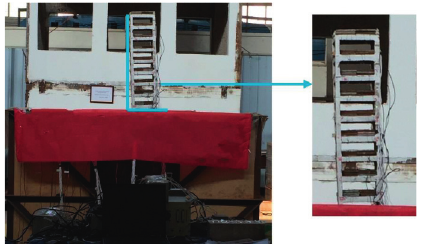
Figure 15: Overall inclination of the surface